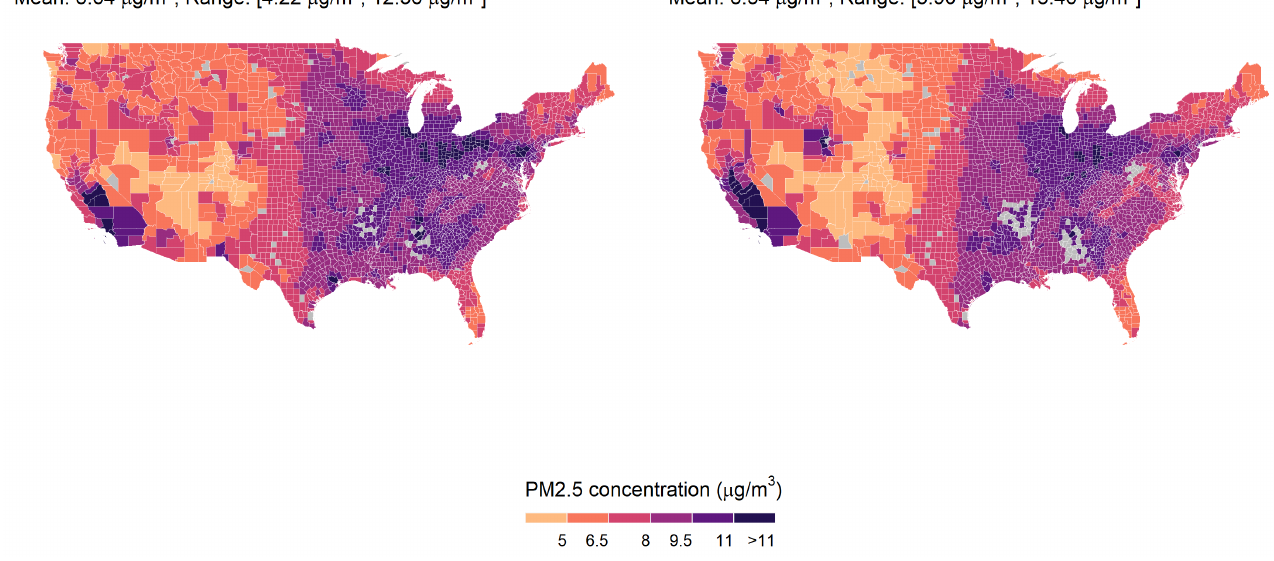
Figure 2. Average annual PM 2.5 concentration by conception year in counties in which at least one conception occurred. Note: Each panel represents average PM 2.5 concentration in counties in the conterminous US in the indicated year. Gray-colored counties are counties where no birth occurred in the respective year.